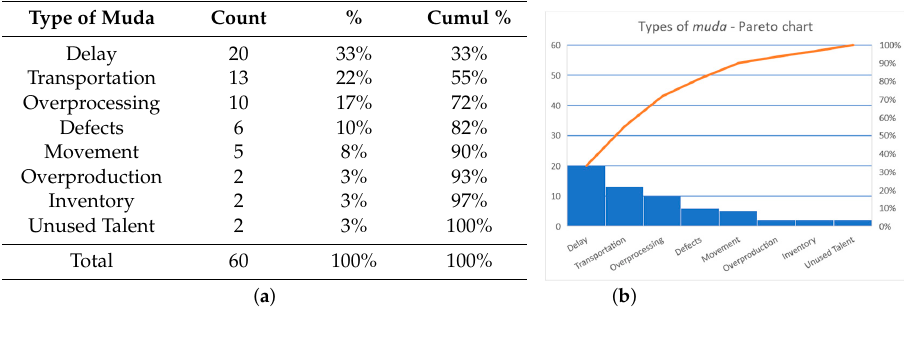
Table 4. Summary of the different types of Muda: (a) Data, (b) Pareto chart.